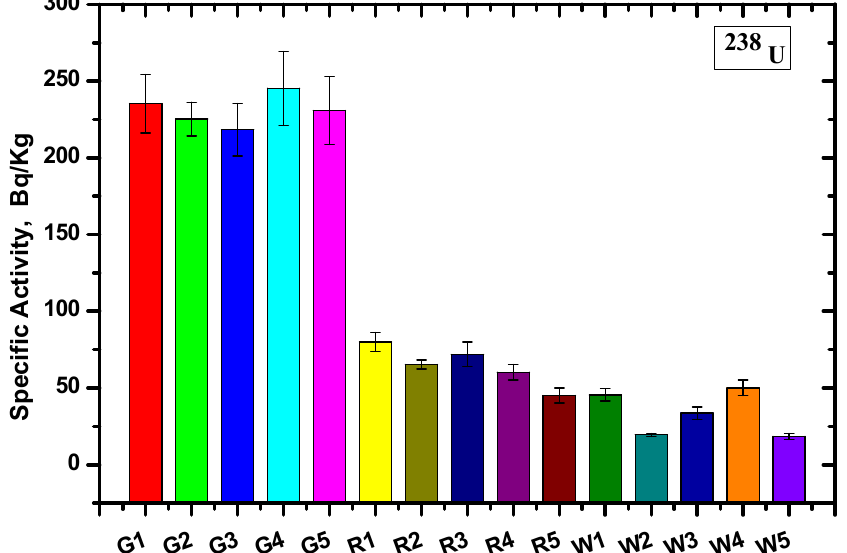
Figure 6. The specific activity for 238 U using the Ra-226 γ -line at 186.2 keV for the different granite samples.